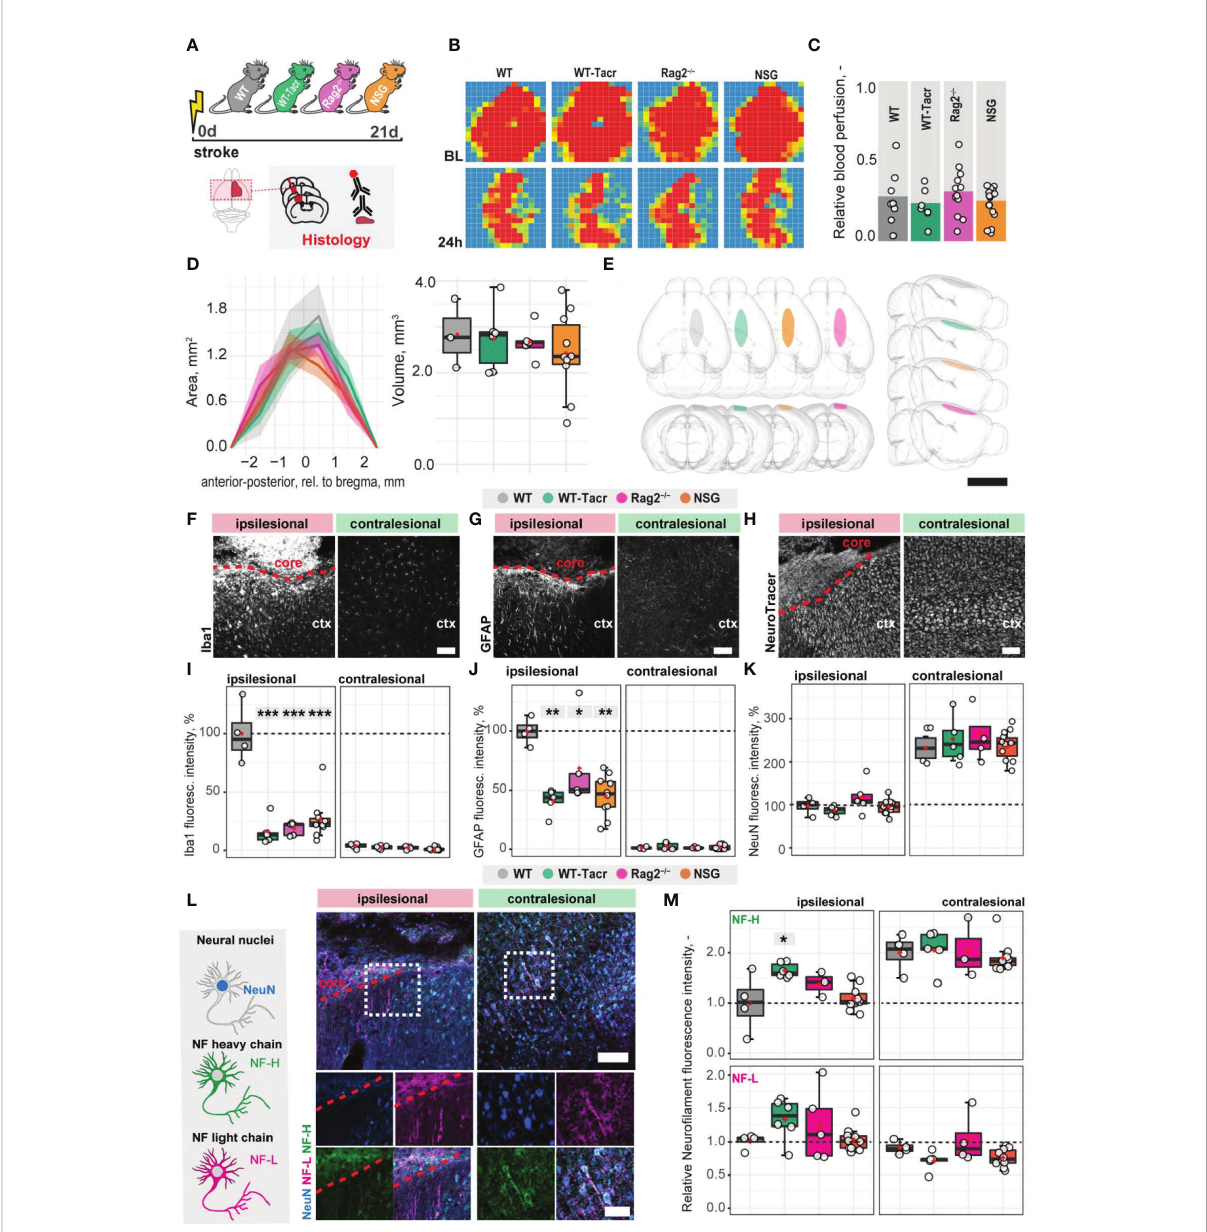
FIGURE 1 Anatomical changes in the stroke pathology of immunosuppressed mice. (A) Schematic representation of experimental set-up and groups of mice: C57BL/6J wildtype (WT), tacrolimus immunosuppressed wildtype (WT-Tacr), recombination activating gene 2 de fi cient mice (Rag2 – / – ) and NOD scid gamma mice (NSG). (B) Representative images of relative blood perfusion at baseline and 24 h after stroke induction. (C) Quanti fi cation of cerebral blood perfusion of the injured hemisphere at 24 h following injury relative to baseline blood perfusion. (D) Quanti fi cation of stroke area and stroke volume at 21 dpi. (E) 3D reconstruction of stroke location within a brain template. Scale bar: 1 cm. (F) Representative histological overview of activated microglia/macrophages (Iba1 + ) (G) reactive astrocytes (GFAP + ) and (H) neural nuclei (NeuroTracer) at the ipsi- and contralesional hemisphere of WT mouse. Scale bar: 100 µm. (I) Quanti fi cation of relative (J) Iba1 + , (J) GFAP + and (K) NeuN signal in the contra- and ipsilesional cortex 21 days following injury. (L) Representative histological overview of neural nuclei (NeuN + , blue) and neuro fi lament light (NF- L, magenta) and heavy chain (NF-H, green) of WT mice. Scale bar: 50 µm. (M) Quanti fi cation of relative neuro fi lament light and heavy chain signal in the ischemic and contralesional cortex. Data are shown as mean distributions where the red dot represents the mean. Boxplots indicate the 25% to 75% quartiles of the data. For boxplots: each dot in the plots represents one animal. Line graphs are plotted as mean ± sem. Signi fi cance of mean differences between the groups (baseline hemisphere, contralesional hemisphere, and ipsilesional hemisphere) was assessed using Tukey ’ s HSD. Asterisks indicate signi fi cance: *P < 0.05, **P < 0.01, ***P < 0.001. ctx, cortex; d, days; BL, baseline; dpi, days post injury; NF, neuro fi